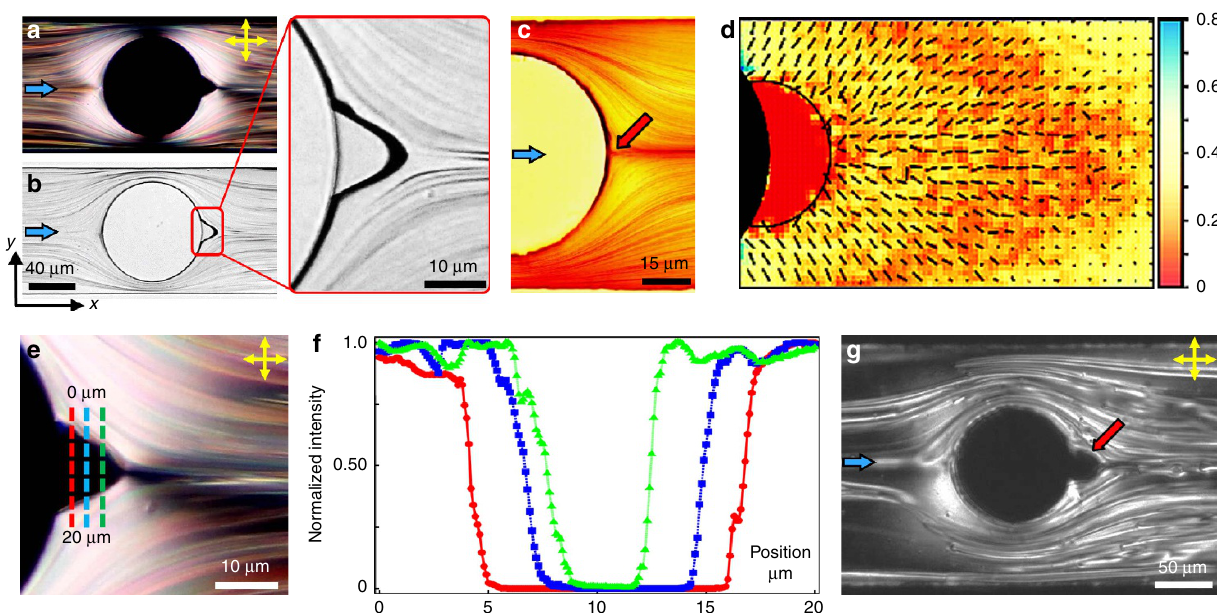
Figure 1 | Cavitation in nematic LC due to flow past a micron-sized pillar. ( a ) Polarized optical micrograph and ( b ) white light micrograph show steady-state cavitation domain in nematic LC, 5CB. The channel and pillar surfaces have homeotropic boundary condition. Right panel: Magnified projection of the cavitating domain. ( c ) Minimum intensity projection of the scattered light over time due to flowing disclination lines. The disclinations were used to trace the streamlines of the LC flow past the micropillar. The cavitating domain is locally stabilized at the hydrodynamic stagnation point (indicated by the red arrowhead) downstream of the micron-sized pillar. For the micrographs shown here, the pillar diameter is 2 r ¼ 80 m m, placed within a 100 m m wide and 15 m m deep microchannel. ( d ) Map of the local nematic order parameter in proximity of the cavitation domain obtained from MD simulations (see attached colour bar). The area of solid red colour corresponding to vanishing nematic order represents the cavitation. Small dashes in the maps represent the local director field. The length of a dash represents its three-dimensional orientation: shorter dashes have an orientation closer to the normal to the plane of the map. ( e ) Magnified view of the cavitating domain observed between crossed polarizers. The intensity of the transmitted light (normalized by the maximum intensity) is measured along the dashed lines: red, blue and green, and plotted in ( f ). For each line, the maximum value of the normalized intensity (bright regions) is recorded outside the cavitation domain (bulk director is oriented at 45 (cid:2) relative to the polarizers). At the apex of the cavitation domain and further downstream, the director is oriented parallel to the flow direction that appears dark between the crossed polarizers. The gas-filled cavitation domain also appears dark (minimum intensity) due to the total extinction of transmitted light. ( g ) Cavitation domain was also observed under planar surface anchoring conditions, visualized here between crossed